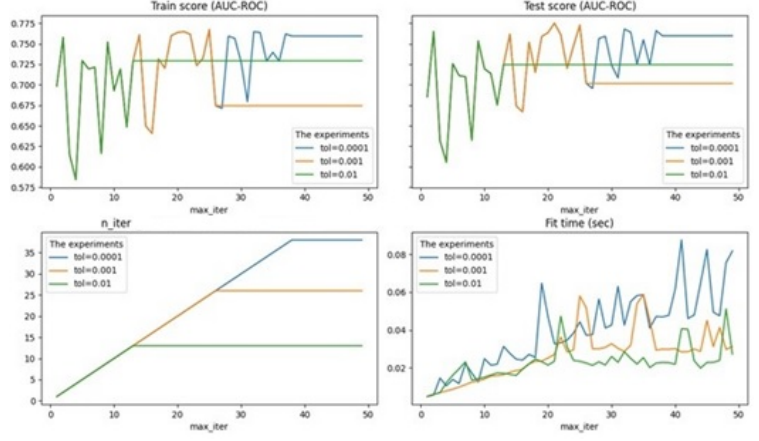
Figure 3. Results of experiments with the tol